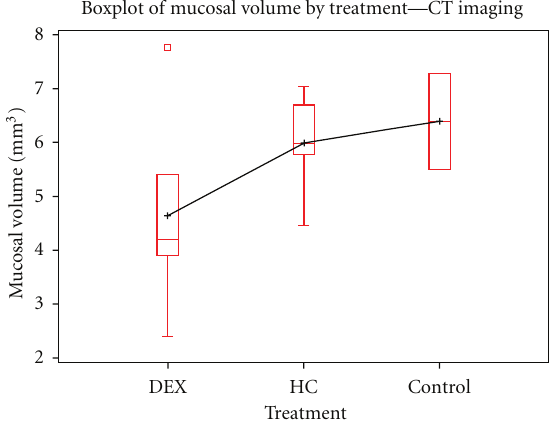
Figure 5: Boxplot of mucosal thickness by Histology. Histology results also show the reduced MT in the DEX-treated specimen compared to the other treatment groups. The findings were sta- tistically significant ( N = 194, α = 0 . 05. χ 2 = 40 . 5267, P -value < 0.0001). Histology measures of MT were made in millimeters (mm).